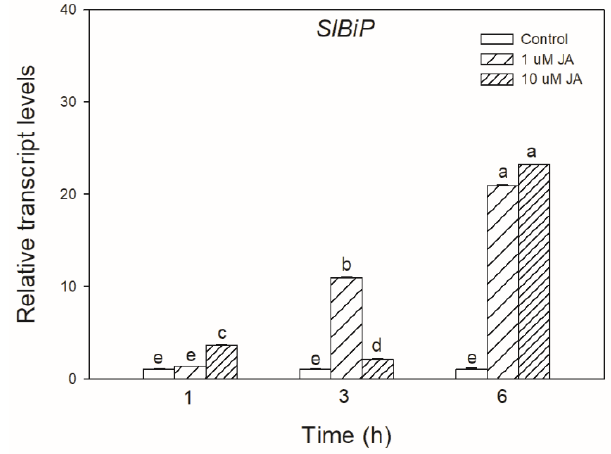
Figure 1. Changes in the transcript accumulation of SlBiP in the leaves of wild-type tomato plants exposed to 1 or 10 μ M jasmonic acid (JA) for 6 h. Results are the means ± SE. Data with different letters indicate significant differences at p < 0.05 level, n = 3.